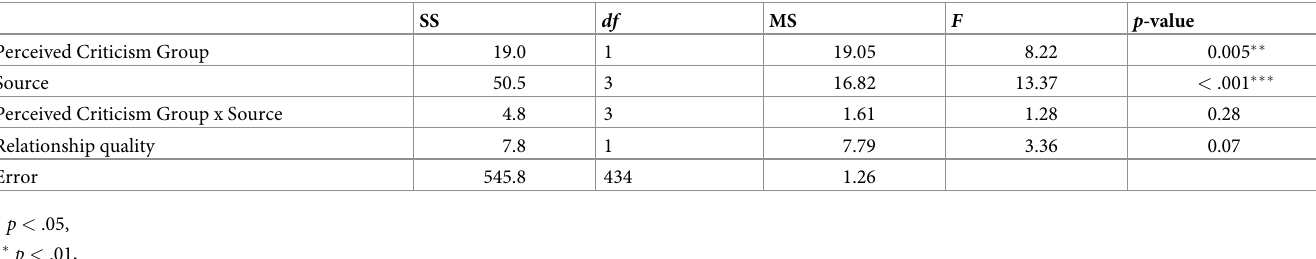
Table 3. Analysis of variance table for levels of relational